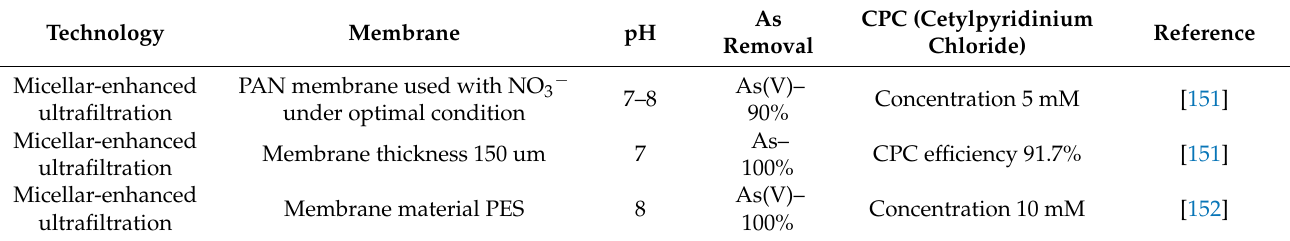
Table 8. Arsenic removal from water by ultrafiltration